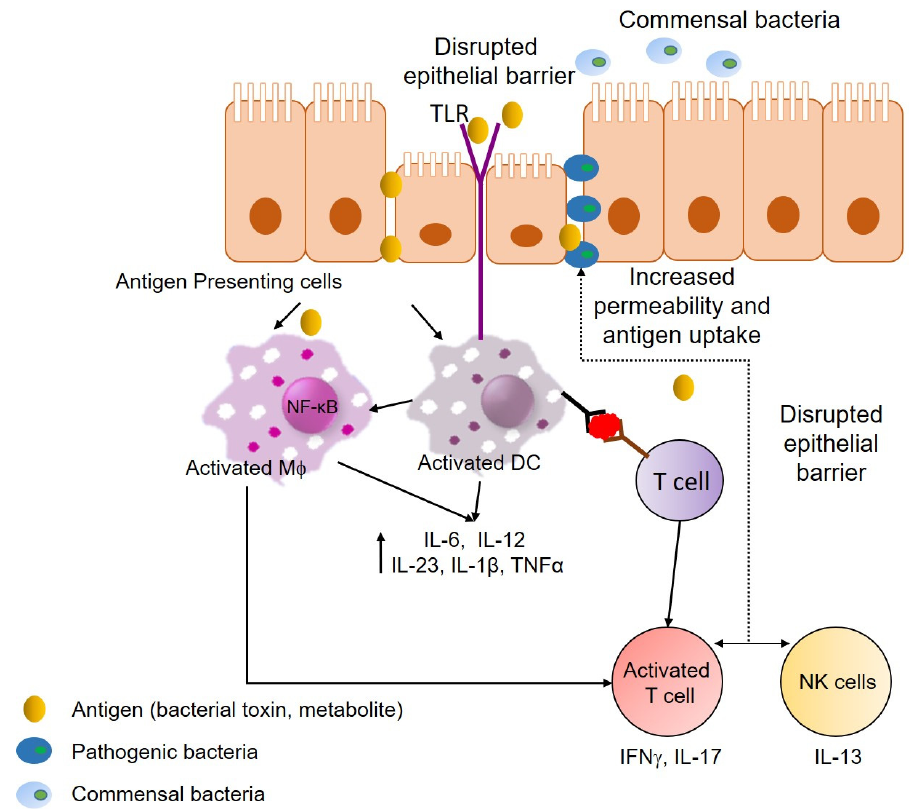
Figure 2. Pathophysiology of inflammatory bowel disease. Disruption of the epithelial layer causes increased permeability of luminal antigens through the epithelial layer. These antigen presenting cells (macrophages—M  and dendritic cells—DC) are activated by recognition of antigens via toll ‐ like receptors (TLR). Activation of the antigen presenting cells results in activation of the nuclear factor kappa ‐ light ‐ chain ‐ enhancer of activated B cells (NF ‐κ B) pathway, which stimulates the production of inflammatory cytokines (interleukin (IL) ‐ 6, IL ‐ 12, IL ‐ 23, IL ‐ 1 β , and TNF α ) via increased